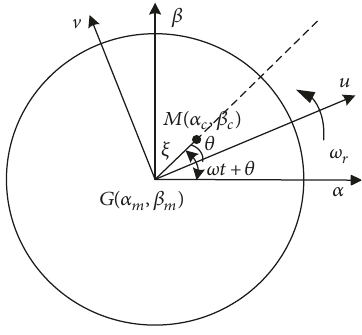
Figure 2: Diagram of rotor mass